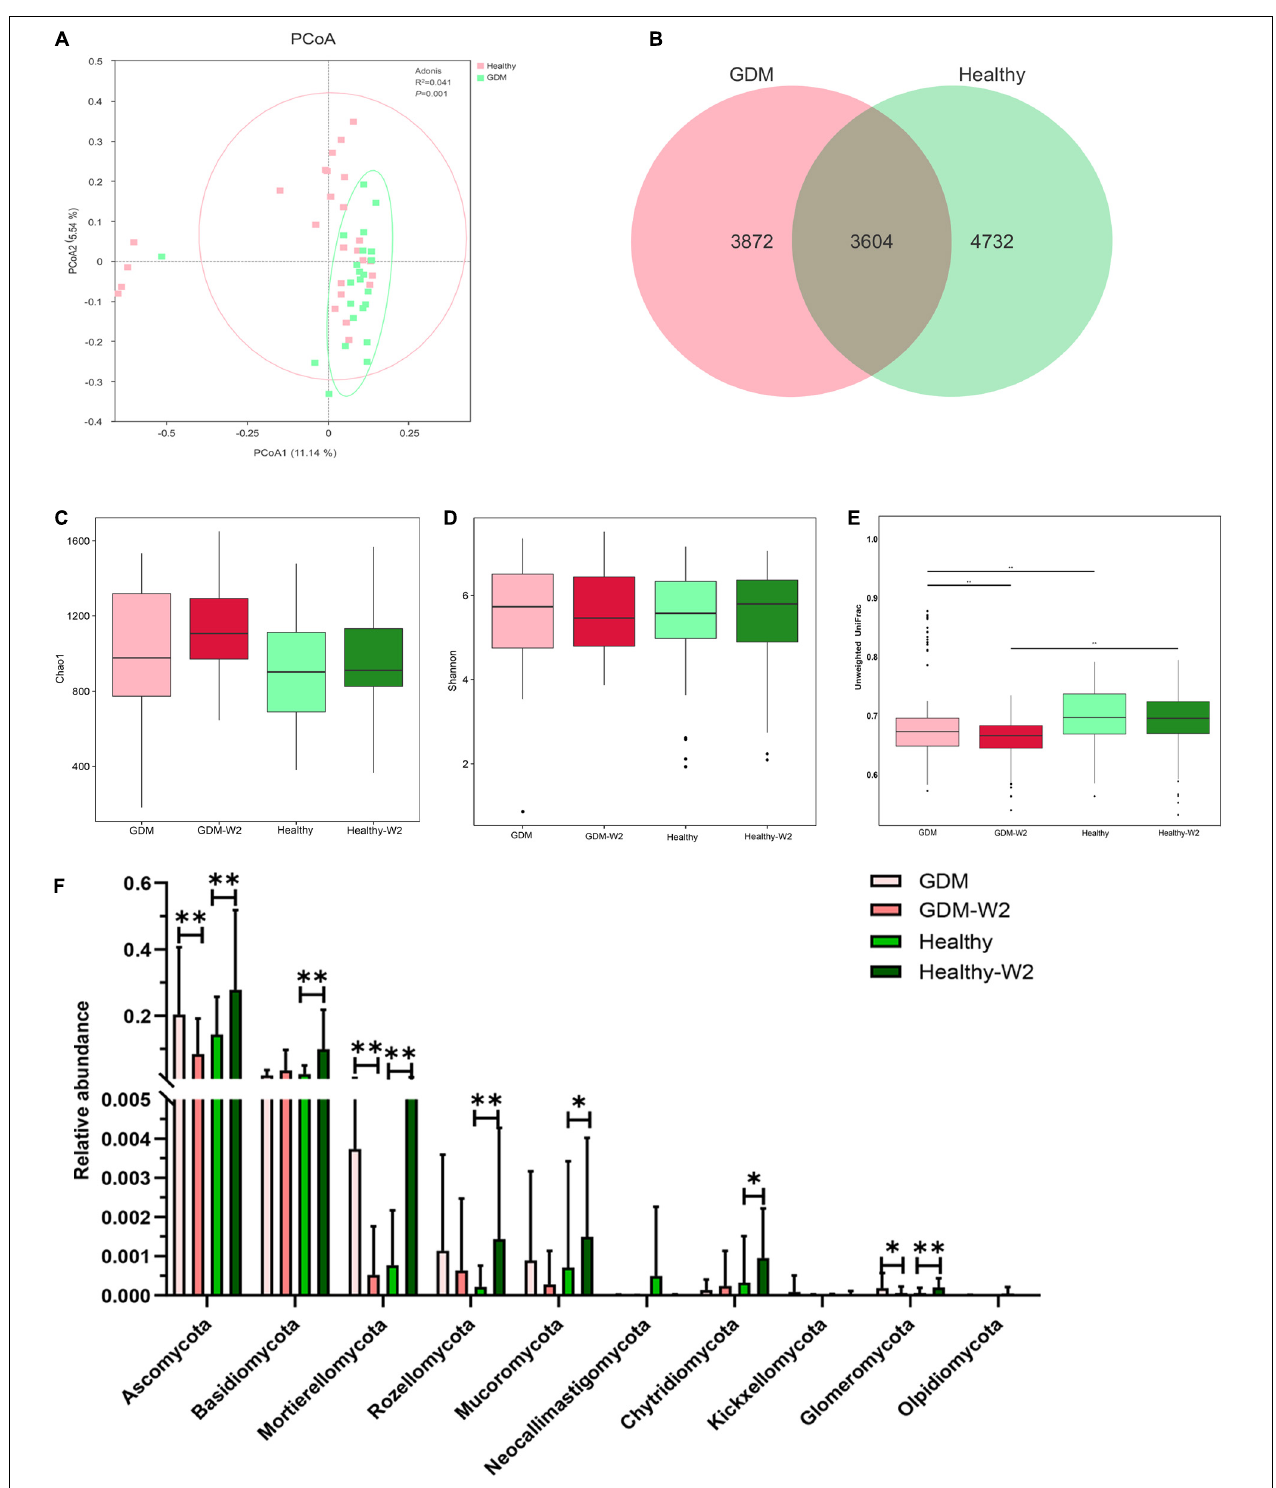
FIGURE 1 | Comparison of the gut mycobiome composition between the GDM ( n = 23) and healthy ( n = 26) groups. (A) Principal coordinate analysis (PCoA) at the OTU level between the GDM and healthy groups at enrollment. (B) Venn diagram illustrating the overlap of the OTUs identified in the mycobiome between the GDM and healthy groups at enrollment. (C) Alpha-diversity based on the Chao 1 index at the OTU level. Mann-Whitney test. (D) Alpha-diversity based on the Shannon index at the OTU level. Mann-Whitney test. (E) Beta-diversity based on the unweighted UniFrac distance. Mann-Whitney test. (F) Comparison of the relative abundances at the phylum level among the four GDM and non-GDM groups. Mann-Whitney test, ∗∗ P < 0.01, ∗ P < 0.05.